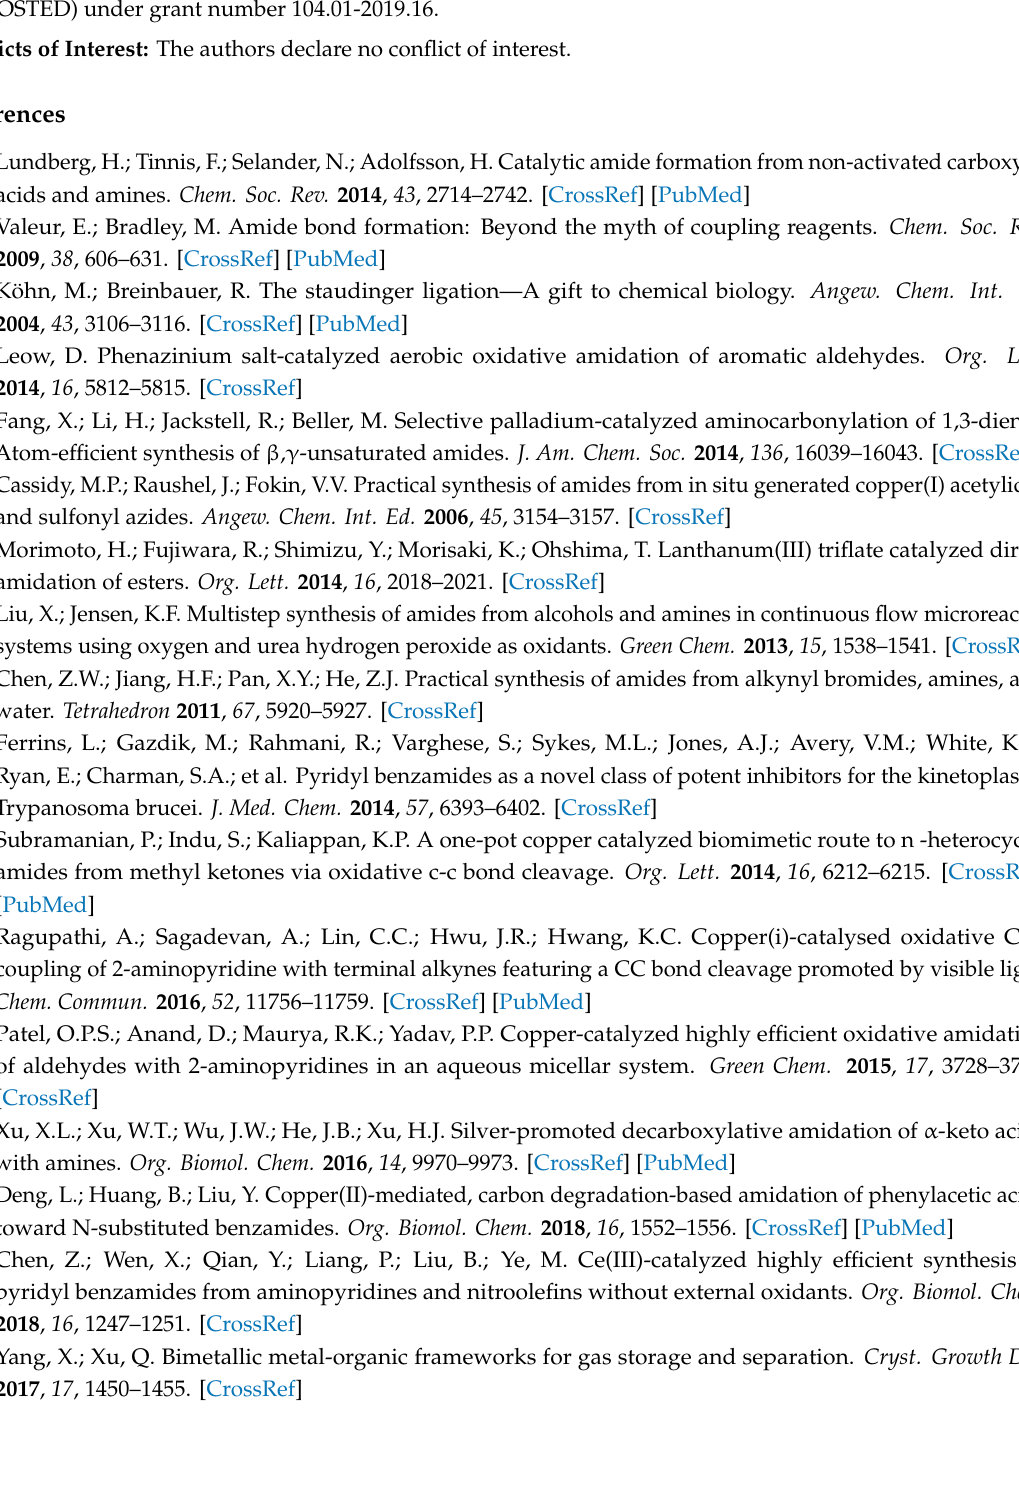
Figure S8: 1 H-NMR spectra of N-(4-methylpyridin-2-yl)benzamide. Figure S9: 13 C-NMR spectra of N-(4-methylpyridin-2-yl)benzamide. Figure S10: 1 H-NMR spectra of 5-methyl-2-phenyl-1H-benzo[d]imidazole. Figure S11: 13 C-NMR spectra of 5-methyl-2-phenyl- 1H-benzo[d]imidazole. Figure S12: 1 H-NMR spectra of N-(5-chloropyridin-2-yl)benzamide. Figure S13: 13 C-NMR spectra of N-(5-chloropyridin-2-yl)benzamide. Figure S14: 1H-NMR spectra of N-(pyridin-2-yl)benzamide. Figure S15: 13 C-NMR spectra of